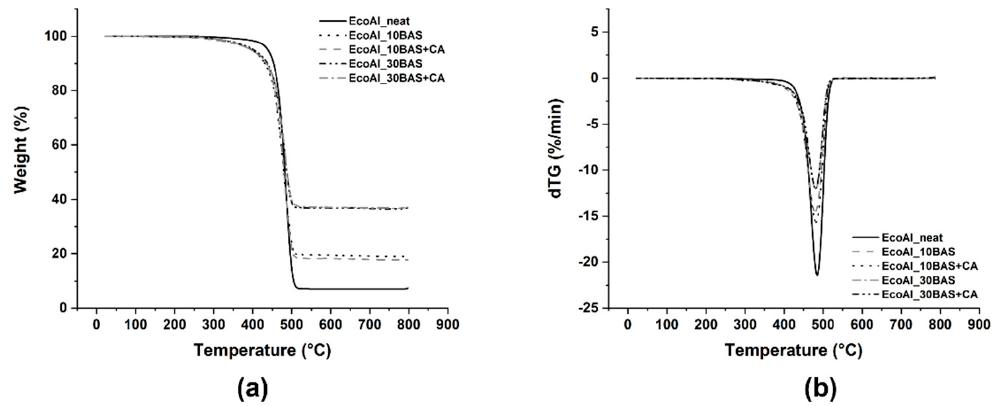
Figure 1. ( a ) TG and ( b ) derivative (dTG) curves for all EcoAllene-based formulations.